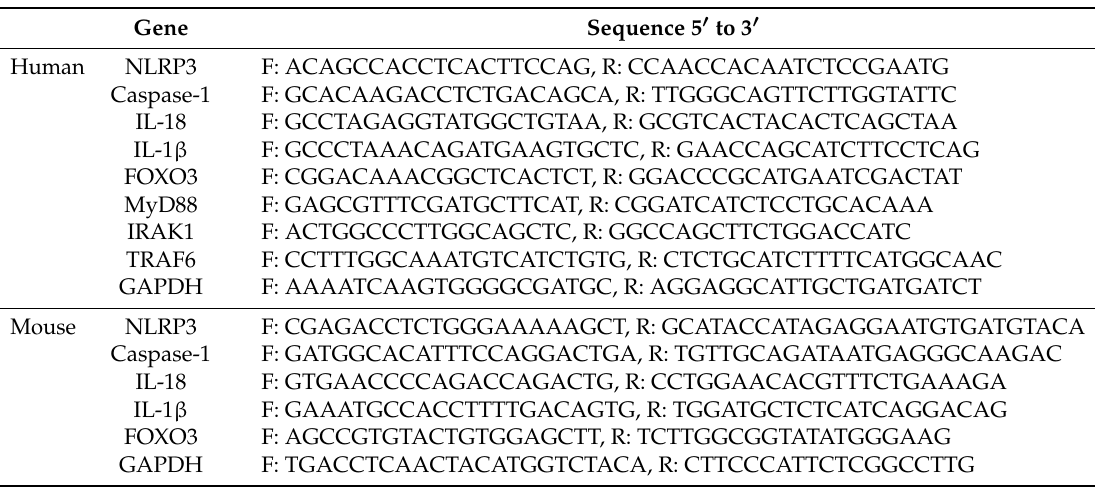
Table 1. Primer sequences used for quantitative